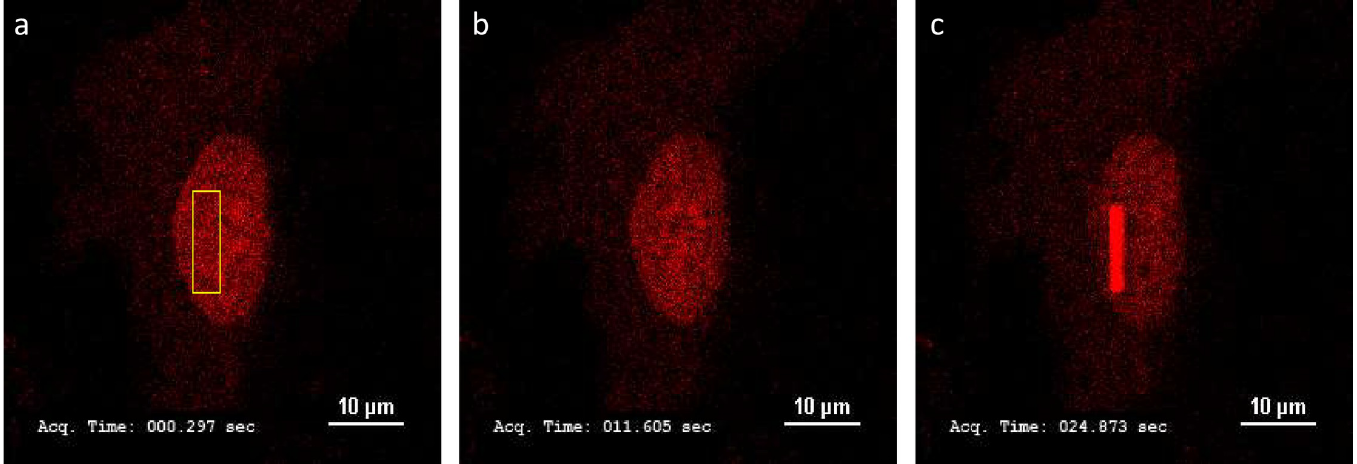
Fig 5. Bespoke Mod3D perfusion chamber. (a) Computer Aided Design (CAD) drawing of microfluidic paths and the 1:4 manifolds. (b) Chamber, culture lid and perfusion lid clamp. (c) A 22x22 mm coverslip is placed on top after cell culture sealed with silicone grease and clamped into place with the PETG clamp. Inlet/ outlet aluminum tubing is bonded in place with RTV